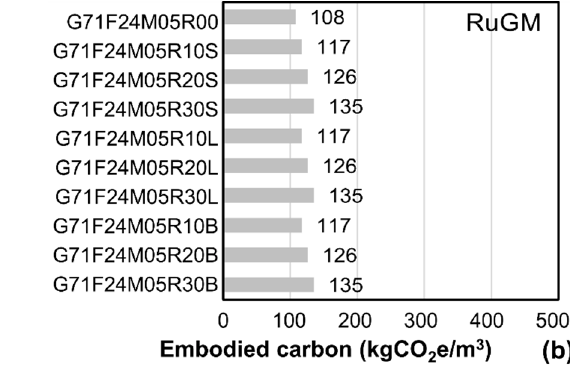
Figure 7. Embodied carbon for: ( a ) CGM, ( b ) RuGM.